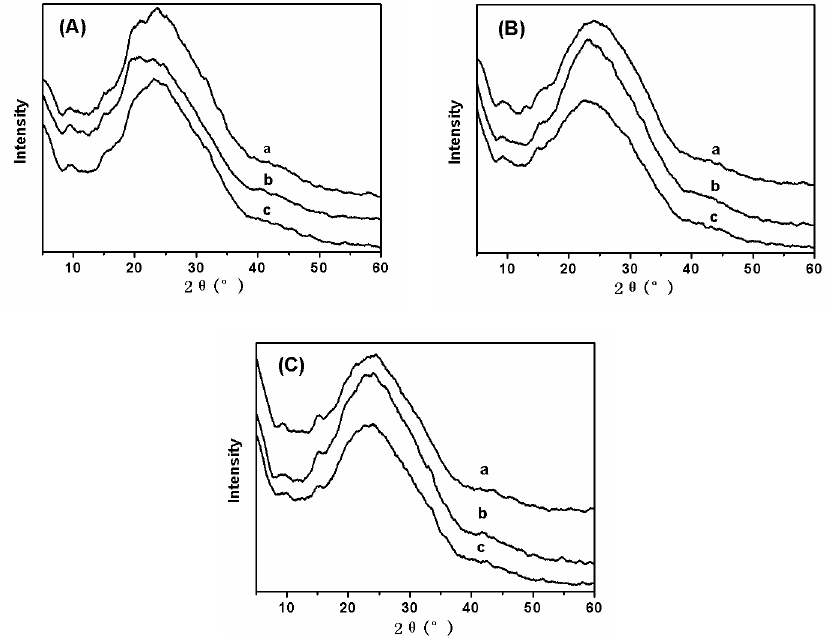
Figure 6. XRD data of fluorescent SF nanofibers with di ff erent fluorescent dyes: ( A ) FS, ( B ) RB, and ( C ) AO. At the same time, the concentrations of fluorescent dyes in electrospinning solution were ( a ) 0.5 wt%, ( b ) 1.0 wt%, and ( c ) 2.0 wt%, respectively. The concentration of SF in electrospinning solution was 10.0